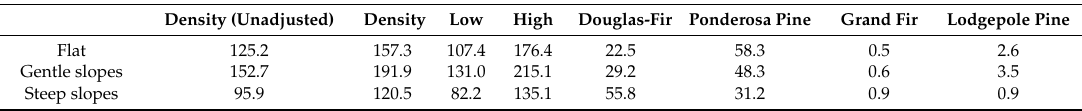
Table 5. Structure (density in trees / ha unadjusted and adjusted) and percent fir and pine species by slope class for the Umatilla National